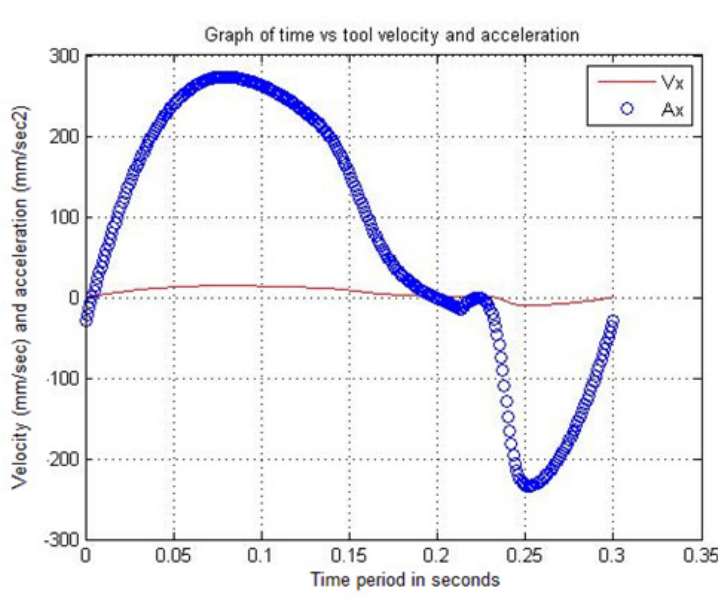
Figure 6: Time period (s) versus velocity (mm) and acceleration (mm/sec 2 ) of tool for one complete cycle 3.2 Results of the ADAMS analysis: